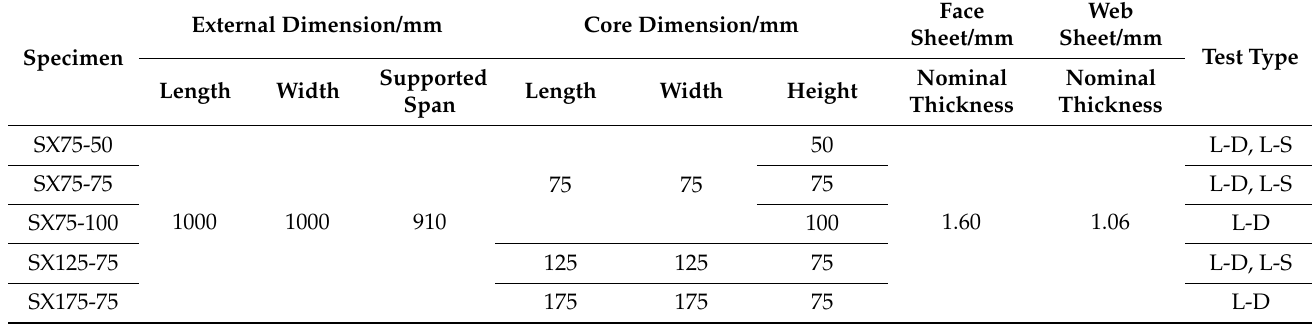
Table 1. Details of the